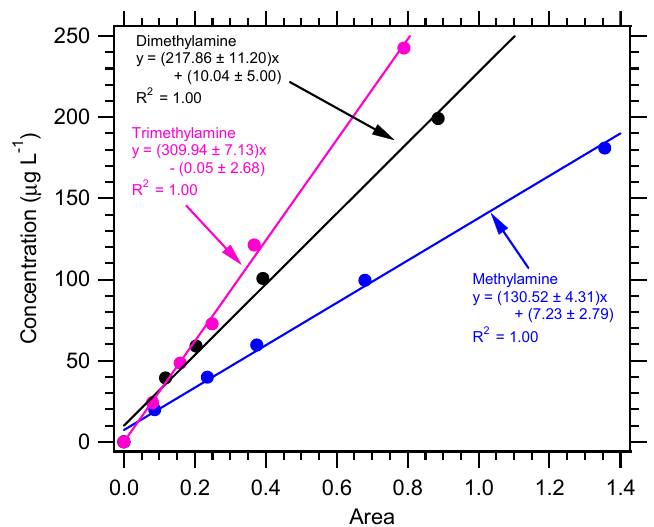
Figure 4. Typical calibration curves for methylamine, dimethylamine, and trimethylamine employing the Thermo Scientific Dionex IonPac CS-19 (4 × 250 mm) column using the separation method described in the main text. Uncertainties with the least square regression are one standard deviation.